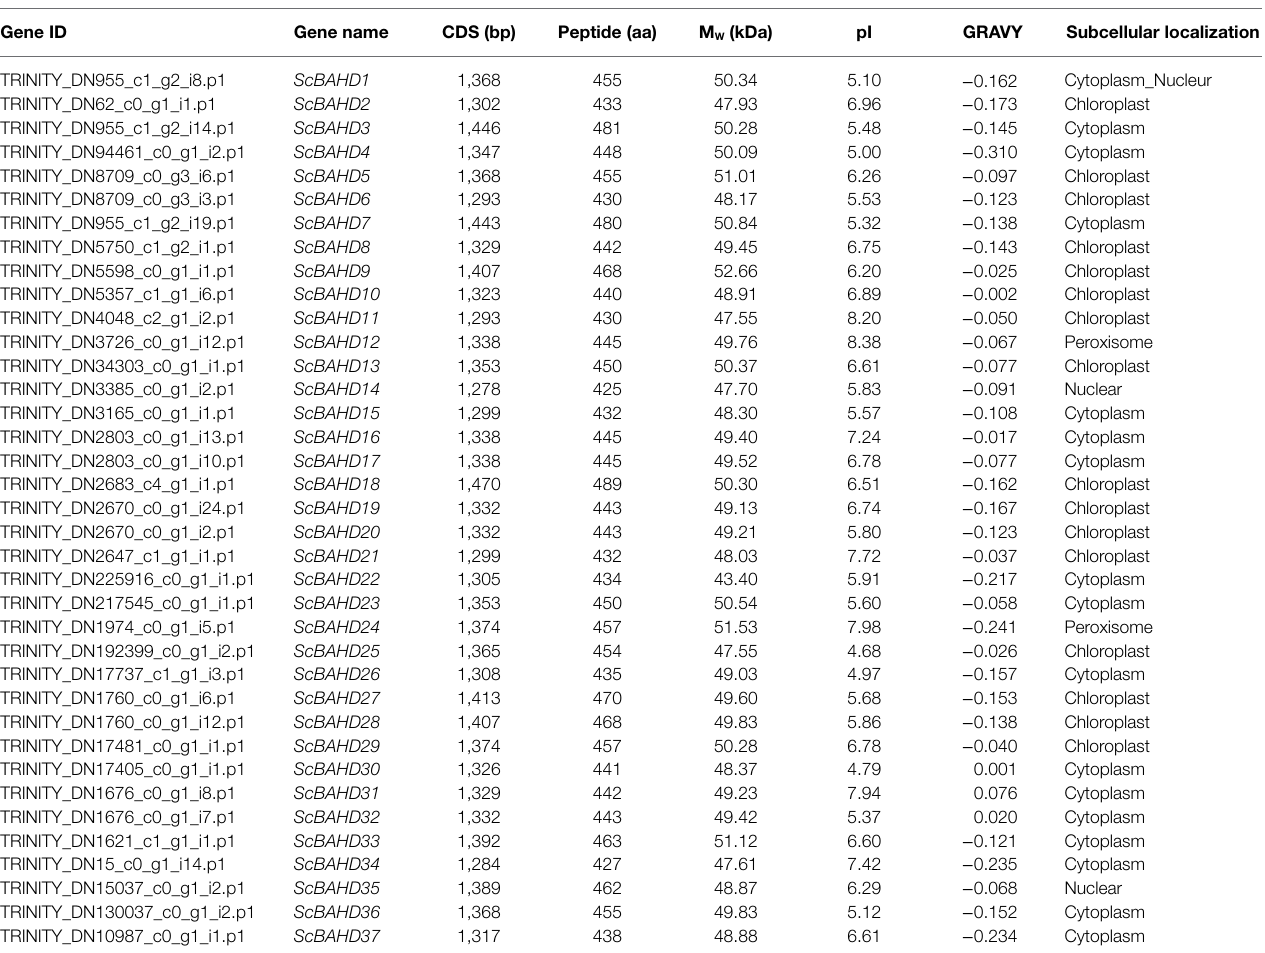
TABLE 1 | Molecular characteristics of ScBAHD genes in Schisandra chinensis